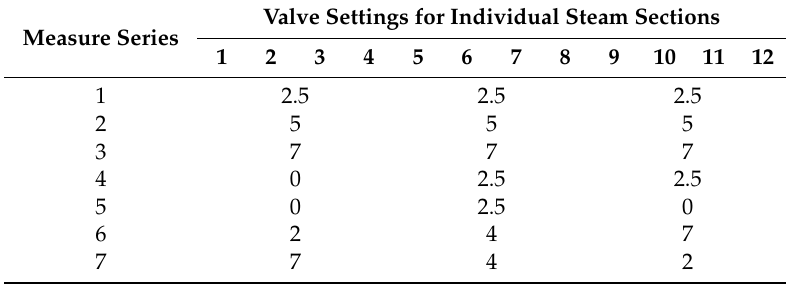
Table 1. Valve settings for individual steam sections in subsequent measurements.